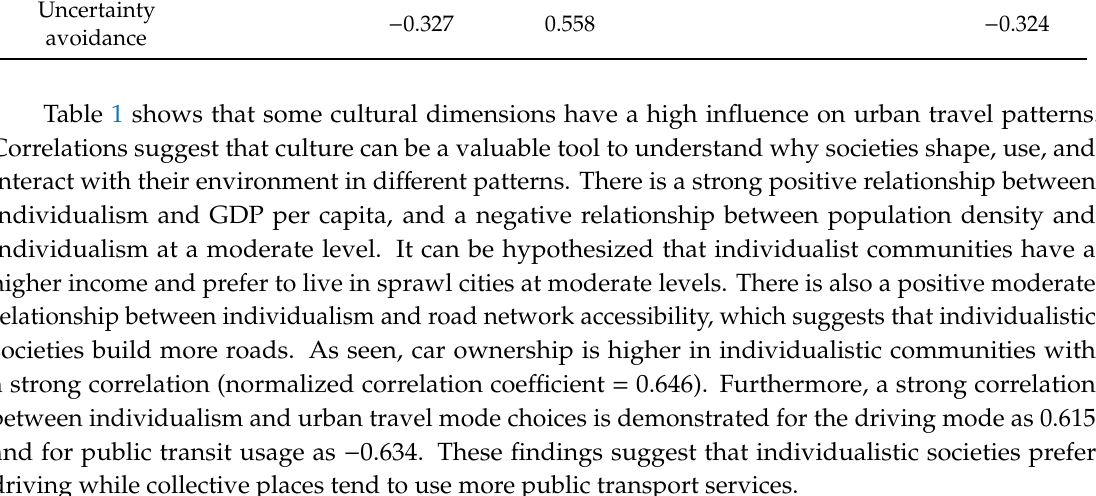
Table 1. Normalized correlation coe ffi cient between culture dimensions and urban indicators. Public Road Population GDP Per Car Drive % Transport % Accessibility Density Capita Ownership Individualism 0.646 0.615 − 0.634 0.450 − 0.351 0.670 Power Distance − 0.345 − 0.469 0.591 − 0.325 − 0.502 Masculinity 0.320